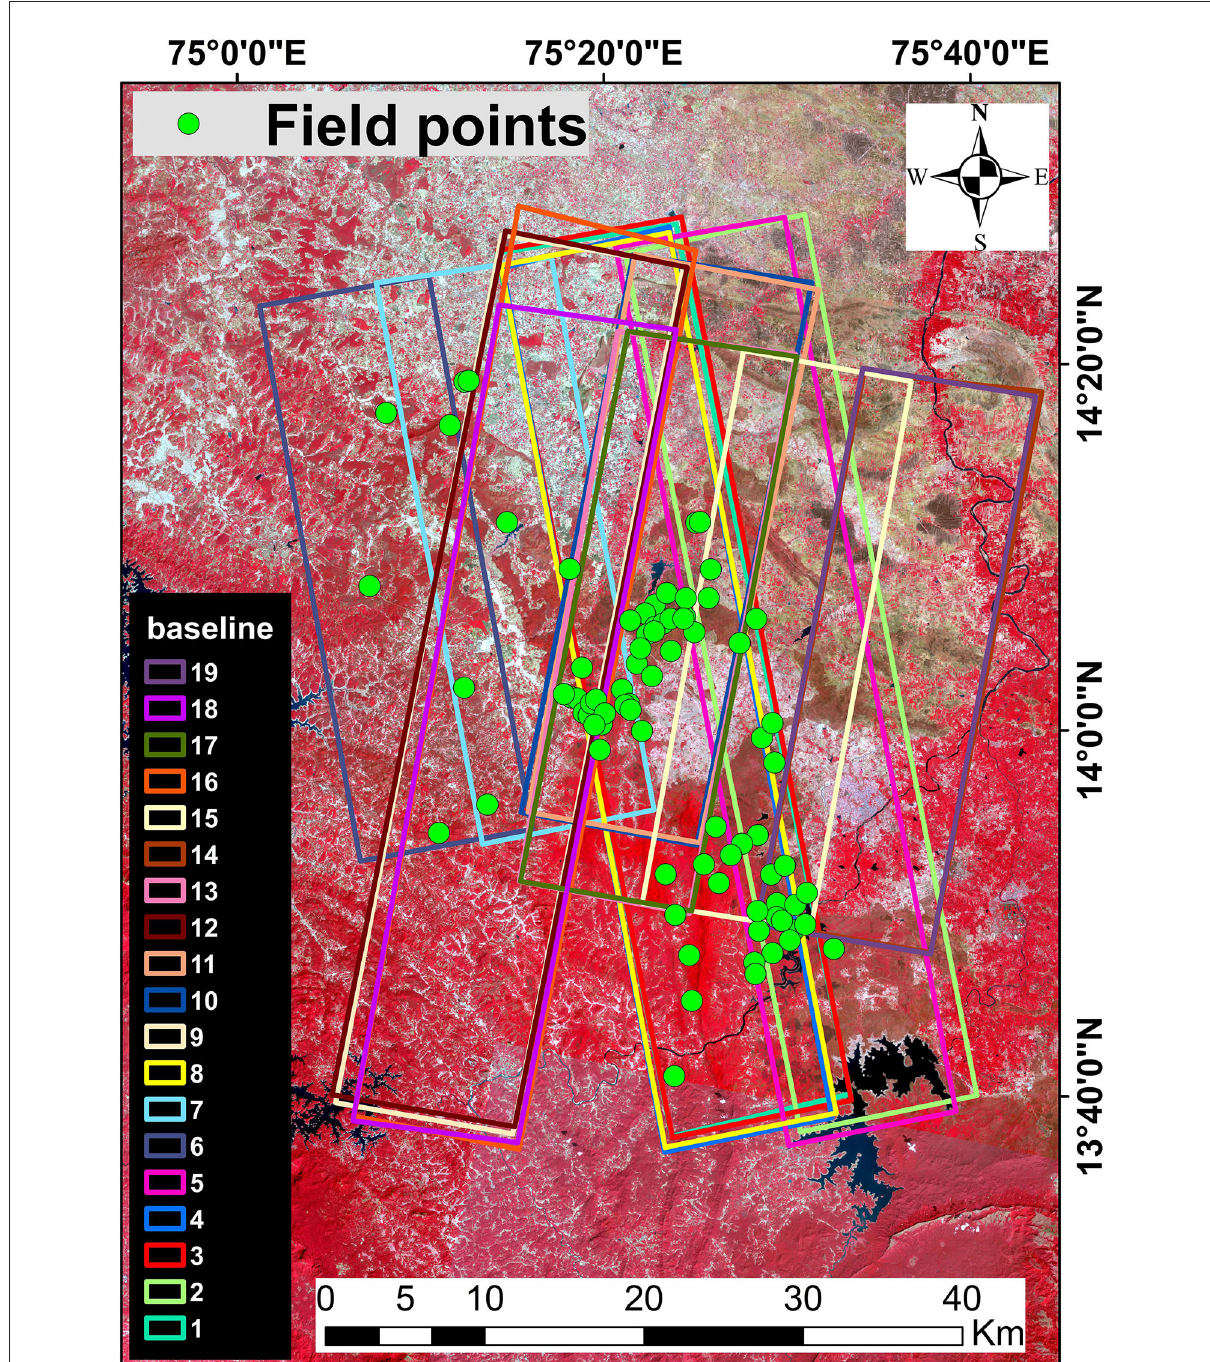
FIGURE3 All TanDEM-X acquisitions over the test site with the location of field validation plots. Distinct colors are given to differentiate the 19 baselines. The base image used is a Landsat-8 False Color Composite (FCC) image of